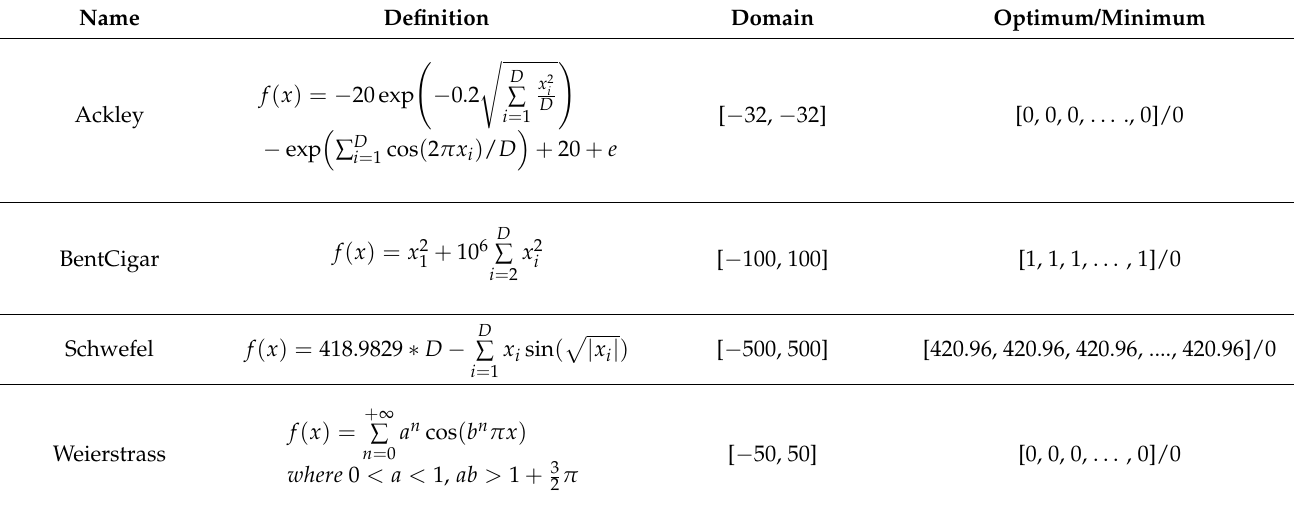
Table 2. Four tested functions.